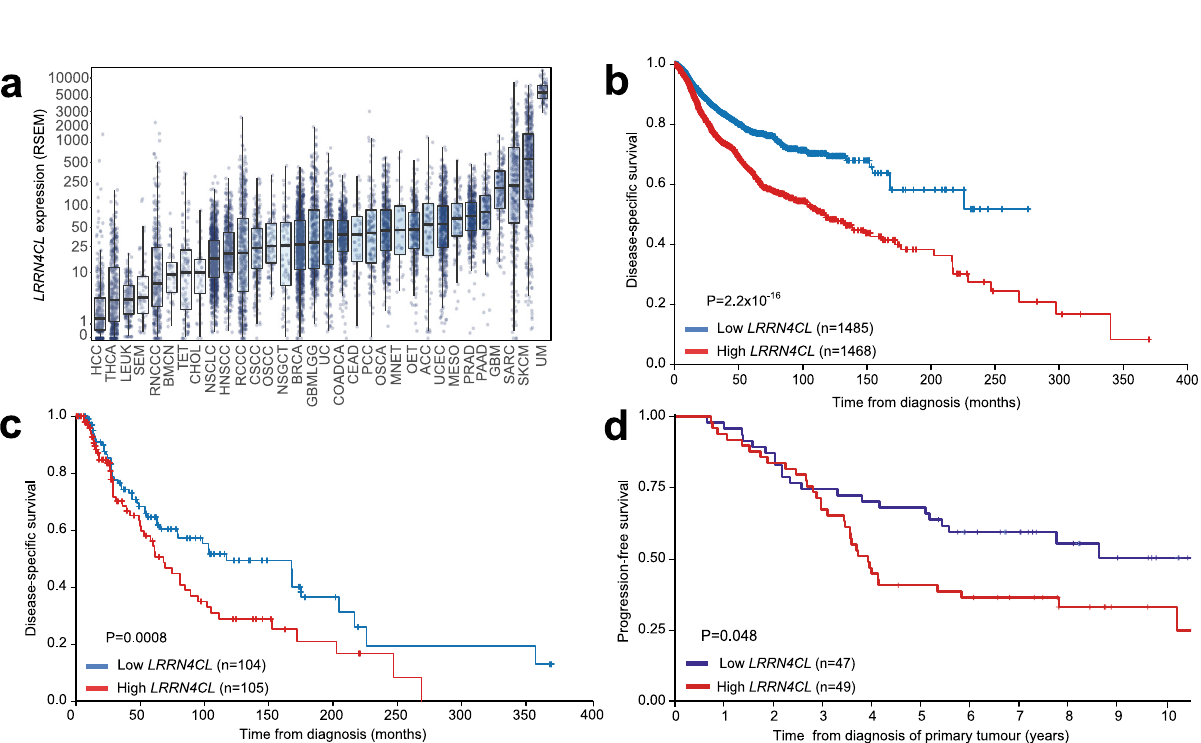
Fig. 5 LRRN4CL expression in tumours and its correlation to patient outcome. a LRRN4CL expression (RSEM) amongst different tumour types (data from TCGA). Bar represents the median, box represents the interquartile range. Whiskers represent 1.5 * IQR. Abbreviations: HCC hepatocellular carcinoma, THCA well-differentiated thyroid cancer, LEUK leukaemia, SEM seminoma, RNCCC renal non-clear cell carcinoma, BMCN mature B-cell neoplasms, TET thymic epithelial tumour, CHOL cholangiosarcoma, NSCLC non-small cell lung cancer, HNSCC head and neck squamous cell carcinoma, RCCC renal clear cell carcinoma, CSCC cervical squamous cell carcinoma, OSCC oesophageal squamous cell carcinoma, NCGCT non-seminomatous germ cell tumour, BRCA invasive breast carcinoma, GBMLGG diffuse glioma, UC bladder urothelial carcinoma, COADCA colorectal adenocarcinoma, CEAD cervical adenocarcinoma, PCC pheochromocytoma, OSCA oesophagogastric neuroepithelial tumour, MNET miscellaneous neuroepithelial tumour, OET ovarian epithelial tumour, ACC adrenocortical carcinoma, UCEC endometrial carcinoma, MESO pleural mesothelioma, PRAD prostate adenocarcinoma, PAAD pancreatic adenocarcinoma, GBM glioblastoma, SARC sarcoma, SKCM cutaneous melanoma, UM uveal melanoma. b Kaplan – Meier curves for disease- speci fi c survival across all cancer patients from the TCGA dataset. Expression levels of LRRN4CL as lower 25th percentile ( ‘ low LRRN4CL ’ ) or upper 25th percentile ( ‘ high LRRN4CL ’ ). Cox Log-rank P value, age- and sex-adjusted. c Kaplan – Meier curves for disease-speci fi c survival in cutaneous melanoma patients from the TCGA dataset. Expression levels of LRRN4CL as lower 25th percentile ( ‘ low LRRN4CL ’ ) or upper 25th percentile ( ‘ high LRRN4CL ’ ). Cox Log-rank P value, age- and sex-adjusted. d Kaplan – Meier curves for progression-free survival in cutaneous melanoma patients from the phase III adjuvant AVAST-M dataset 15 . Expression levels of LRRN4CL as lower 25th percentile ( ‘ low LRRN4CL ’ ) or upper 25th percentile ( ‘ high LRRN4CL ’ ). Cox Log-rank P value, univariate analysis. The numbers in brackets on each graph indicate the number of patient samples per in vivo upregulation of many genes with a known role in pro- downregulation of IFN signalling and upregulation of pro- moting metastasis. Examples include LOXL1 ( lysyl oxidase-like 1 ), metastatic pathways. Interestingly, LRRN4CL is upregulated in with poorer survival of patients that have LOXL1-positive gastric glioma cells that express high levels of MDA9 , which plays an cancer due to distant metastasis 27 ; MMP28 ( matrix metallopepti- important role in cancer progression, particularly during the invasion/metastasis stage 31,32 . The highest expression of dase 28 ), which is a promoter of invasion and metastasis in gastric LRRN4CL in the TCGA dataset was observed in cutaneous and cancer 28 ; HAS1 ( hyaluronan synthase 1 ), which has been shown to uveal melanoma, both of which have a propensity to metastasise play a role in the metastasis of breast cancer cells 29 ; and FPR1 ( formyl peptide receptor 1 ), which is a cell-surface receptor (Fig. 5a). Critically, high expression of LRRN4CL was signi fi cantly expressed by highly malignant human glioma cells that mediates correlated with worse outcome in cancer patients, across all can- metastasis by regulating motility, growth, and angiogenesis cers represented in TCGA (Fig. 5b). High expression of LRRN4CL through interactions with host-derived agonists 30 . Thus, upregu- also correlated with poorer disease-speci fi c survival in cutaneous lated LRRN4CL expression promoted lung-speci fi c metastasis that melanoma patients (as assessed across two independent datasets; was associated with microenvironment-stimulated cell-intrinsic Fig. 5b, c), as well as for other cancer types (Supplementary Fig. 9).